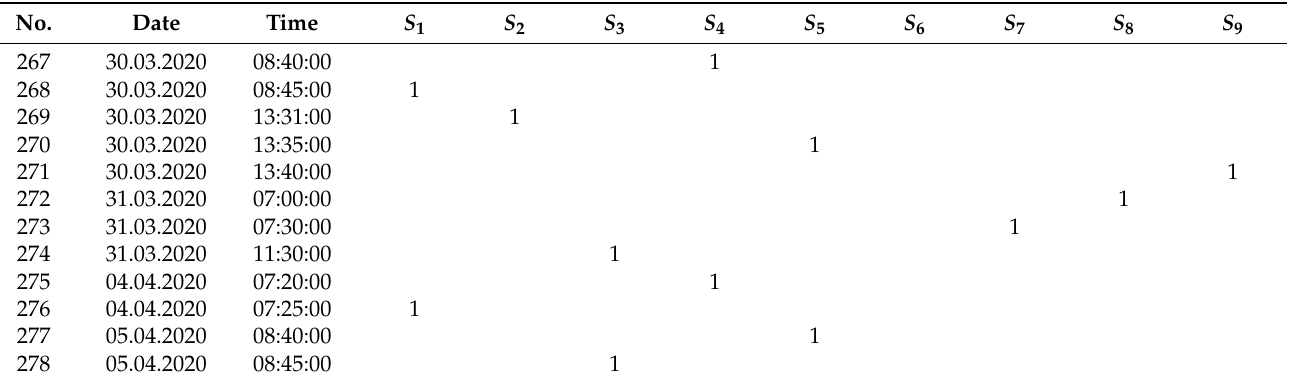
Table 3. Example of a part of database